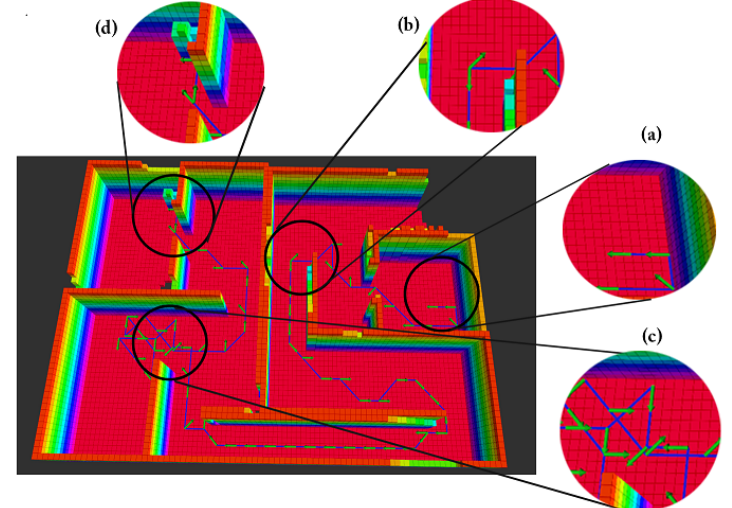
Figure 13. Vehicle traversed path in the U 3 -merged test using RGSA where ( a ) start location, ( b ) direct-path trajectory, ( c ) location of the detected local minimum where A* Planner was invoked to generate path, ( d ) end